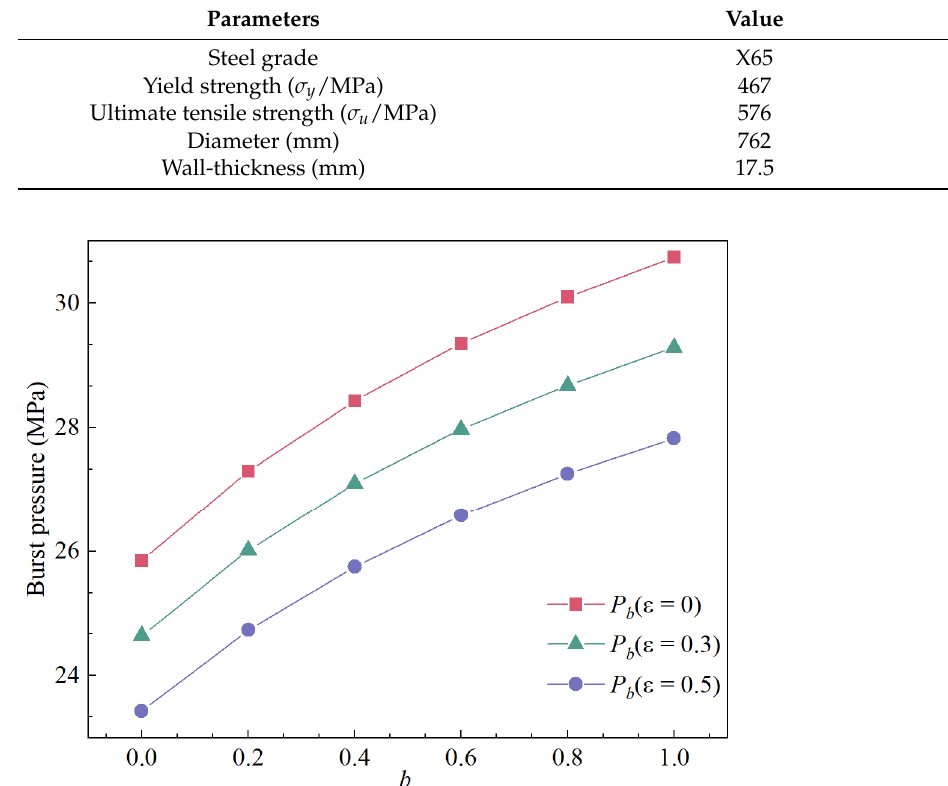
Figure 5. The influence of diameter–thickness ratio on burst pressure.